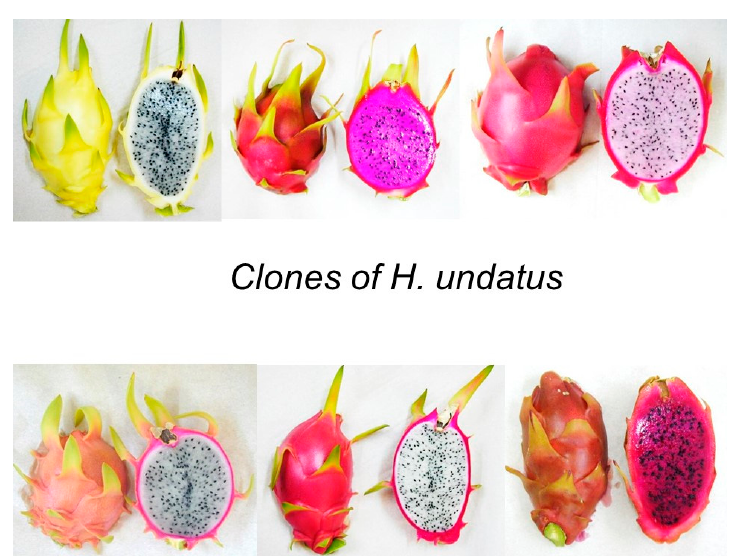
Figure 2. Fruits showing great differences among the clones of one pitaya species Hylocereus undatus. Table 2. Horticultural water use e ffi ciencies (HWUE) of common fruit crops and fruit species with the CAM photosynthesis pathway. Data collected from growers in the Negev Desert of